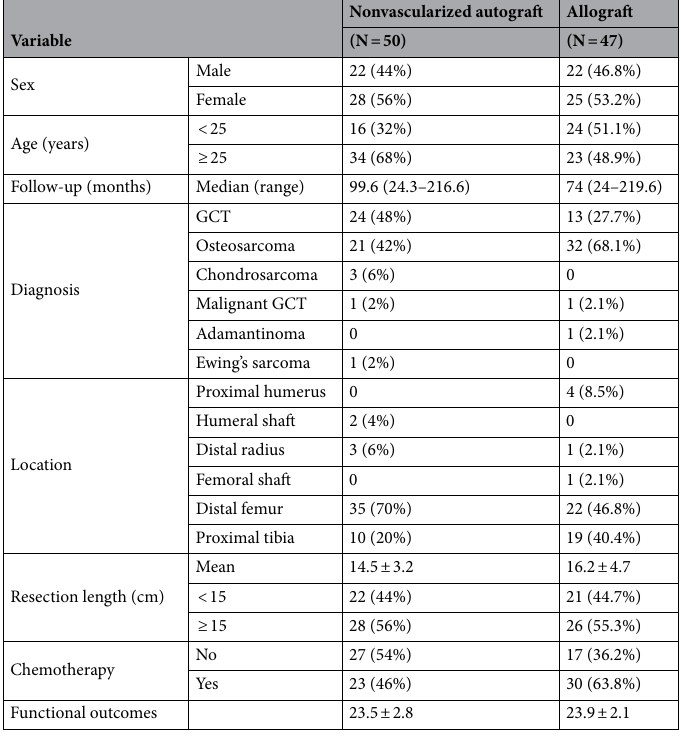
Table 1. Patient